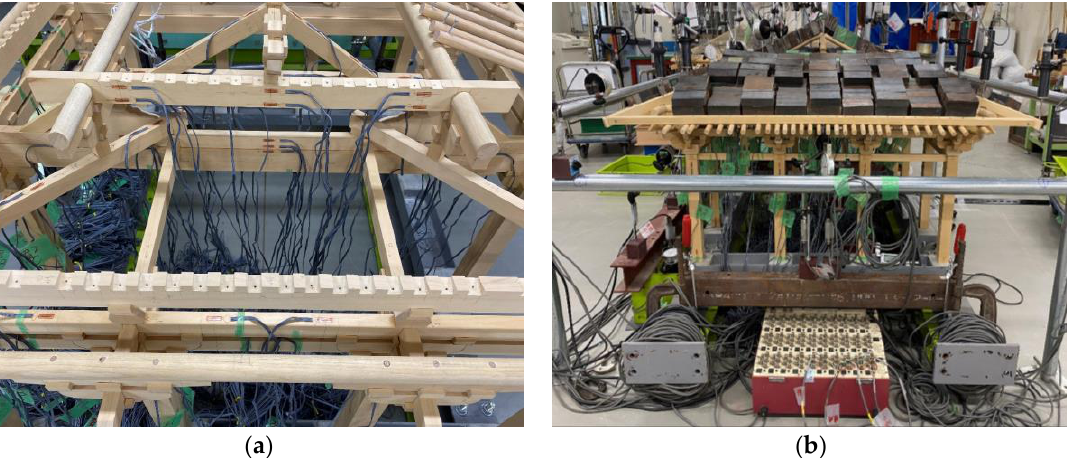
Figure 9. ( a ) Strain gauge attachment position. ( b ) Vertical load experiment setup and iron placement.